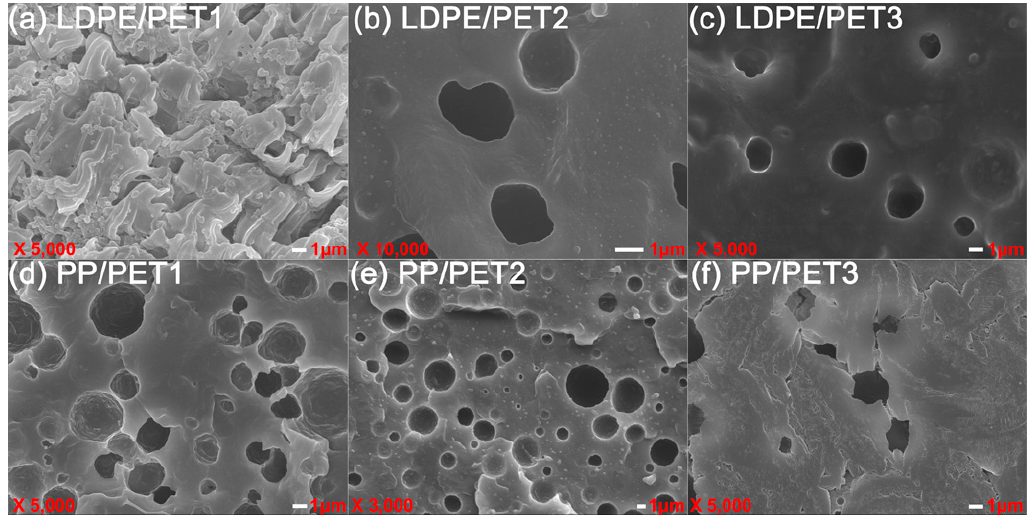
Figure 9. SEM micrographs of LDPE/PET ( a, b, c ) and PP/PET ( d, e, f ) blends with different IV of PET without compatibilizer (80/20).